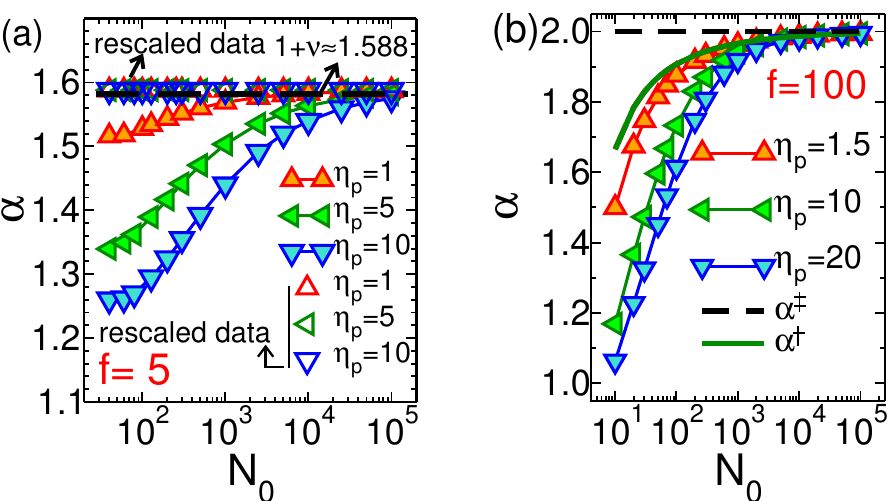
Figure 10. ( a ) The translocation exponent α for the pore-driven case based on the IFTP theory as a function of N 0 for various values of the pore friction η p = 1,5 and 10. Here the external driving force is f = 5, and A ν = 1.15. The rescaled exponent curves are presented for different values of η p . They collapse on a single curve as denoted by rescaled data in the figure, i.e., α † = 1 + ν = 1.588. ( b ) Similar to ( a ) but for end-pulled case and for various values of the pore friction η p = 1.5,10 and 20. Here the external driving force is f = 100. The green solid line presents the rescaled translocation exponent α † while the black dashed curve shows the rescaled exponent α ‡ (for definitions of α † and α ‡ see the